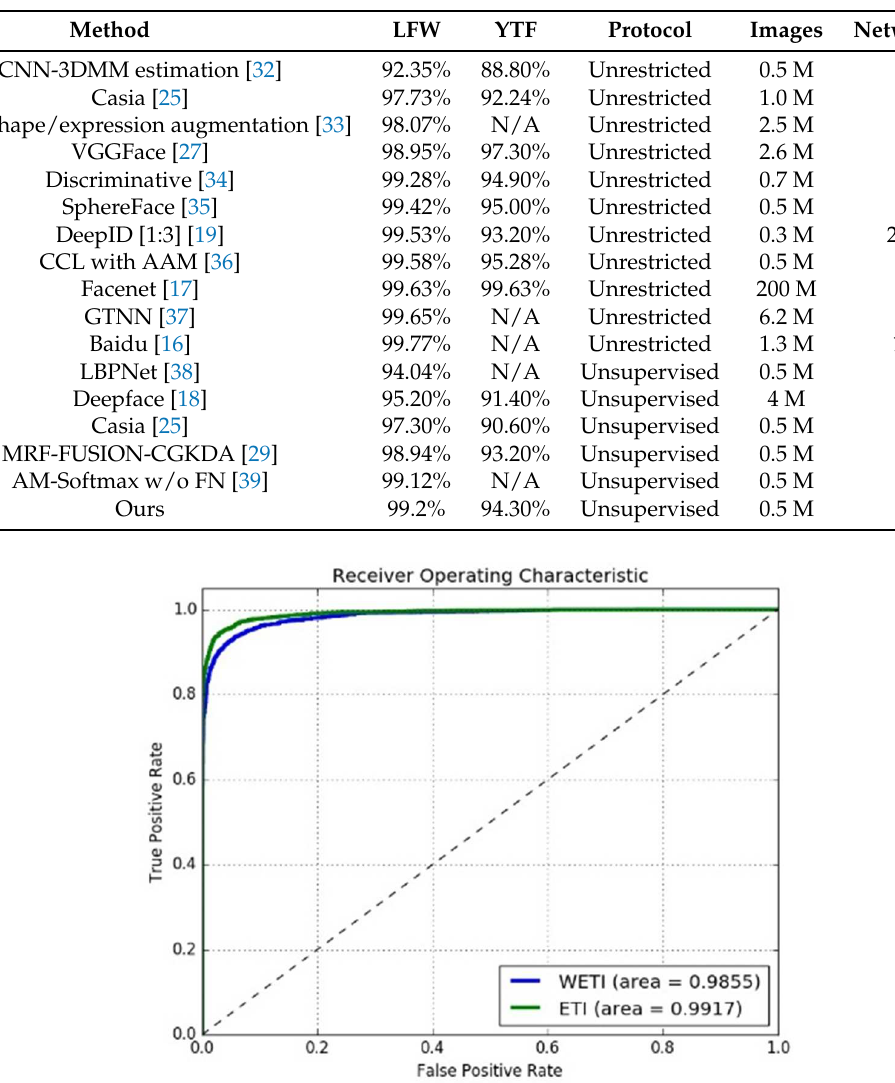
Table 3. Performance on LFW and YTF databases.